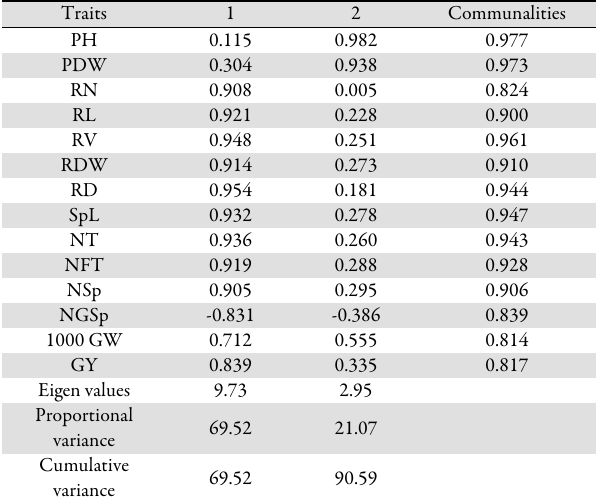
Table 5. Factor analysis for agro-morphological traits in spring wheat cultivars under drought